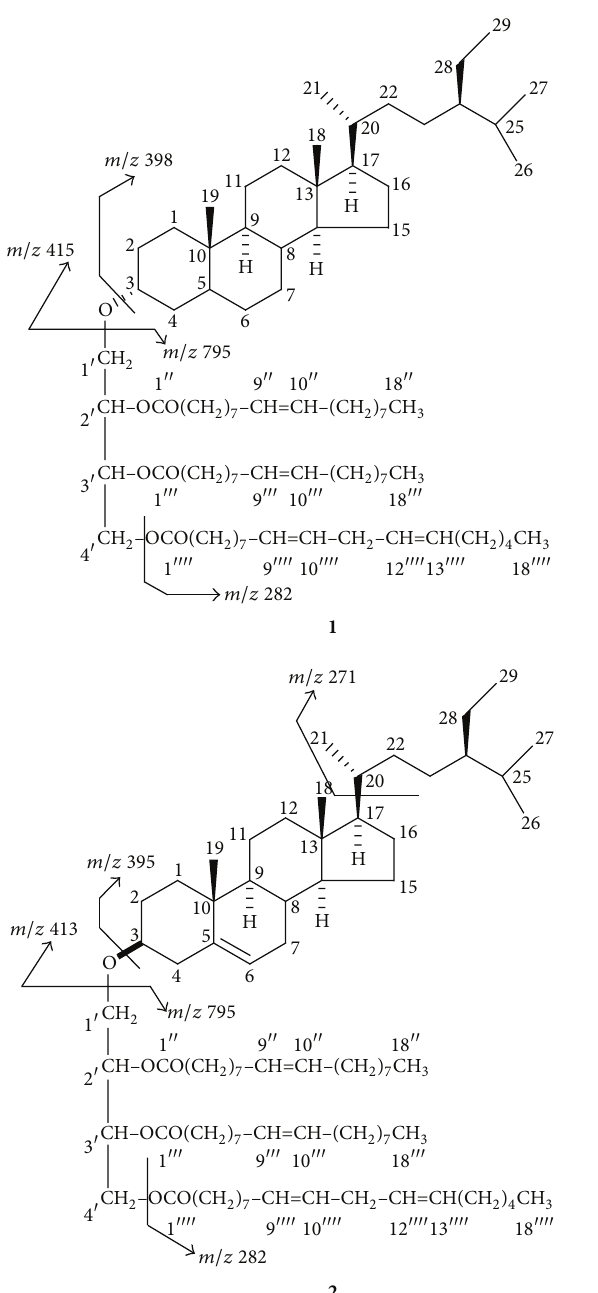
Figure 2: Mass fragmentation pattern of compounds 1 and 2 .